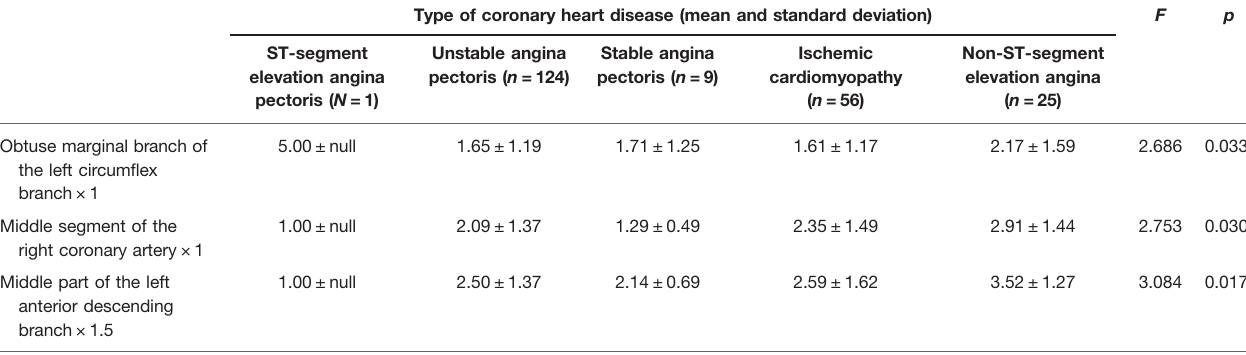
TABLE 3 | Analysis of variance between coronary heart disease type and obtuse marginal branch of the left circum fl ex branch, middle segment of right crown×1, and middle part of the left anterior descending branch×1.5 and total contrast scores. Type of coronary heart disease (mean and standard deviation)